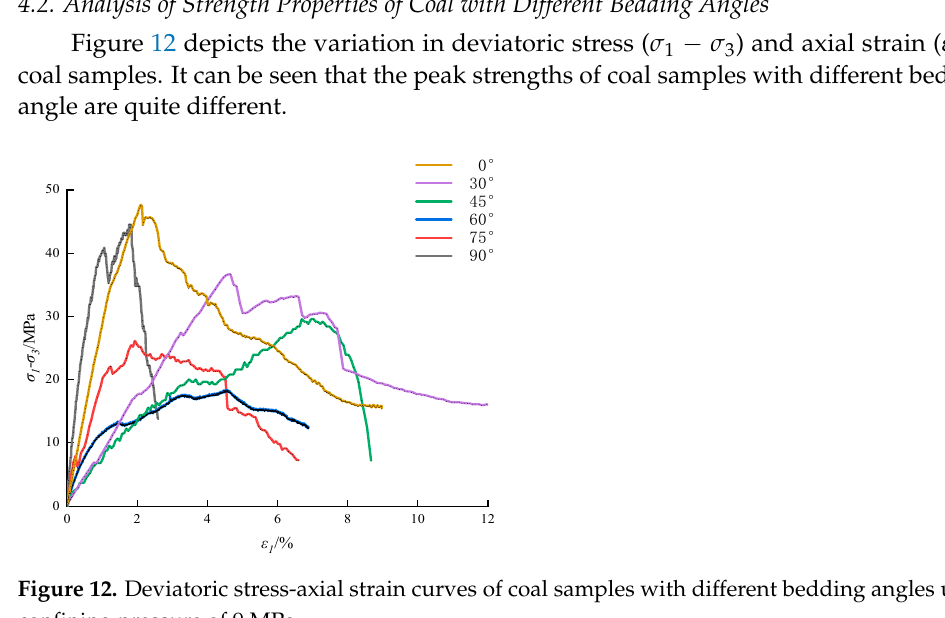
Bedding angle ( θ ) /° Figure 13. Variation in peak stress of coal samples with different bedding angles. 5. Numerical Simulation 5.1. Numerical Modeling Coal is a porous media material, which has obvious inhomogeneous and discontin- uous features, which leads to the complex and changeable mechanical properties and fail- ure patterns of coal. In order to better explore the coal failure mechanics and bedding effects, the DEM was used for numerical simulation. Based on the test results, a two-di- mensional rectangular model with the size of 25 mm × 50 mm was constructed to represent the bedded coal. The computational model comprises approximately 14,000 particles in different gradations and the initial porosity is set to 0.1. The model material parameters are selected as: elastic modulus 2.29 GPa, Poisson’s ratio 0.23, and density 1360 kg/m 3 . The confining pressure of the numerical simulation is consistent with the test (9 MPa). With respect to the special properties of bedding coal and the development of nu- merical analysis technology, an increasing number of researchers have carried out labor- atory tests and numerical analyses. A parallel bonding model was chosen because it can simulate the material damage evolution process [27]. The determination of microscopic parameters is mainly divided into two steps. First, referring to the numerical simulation